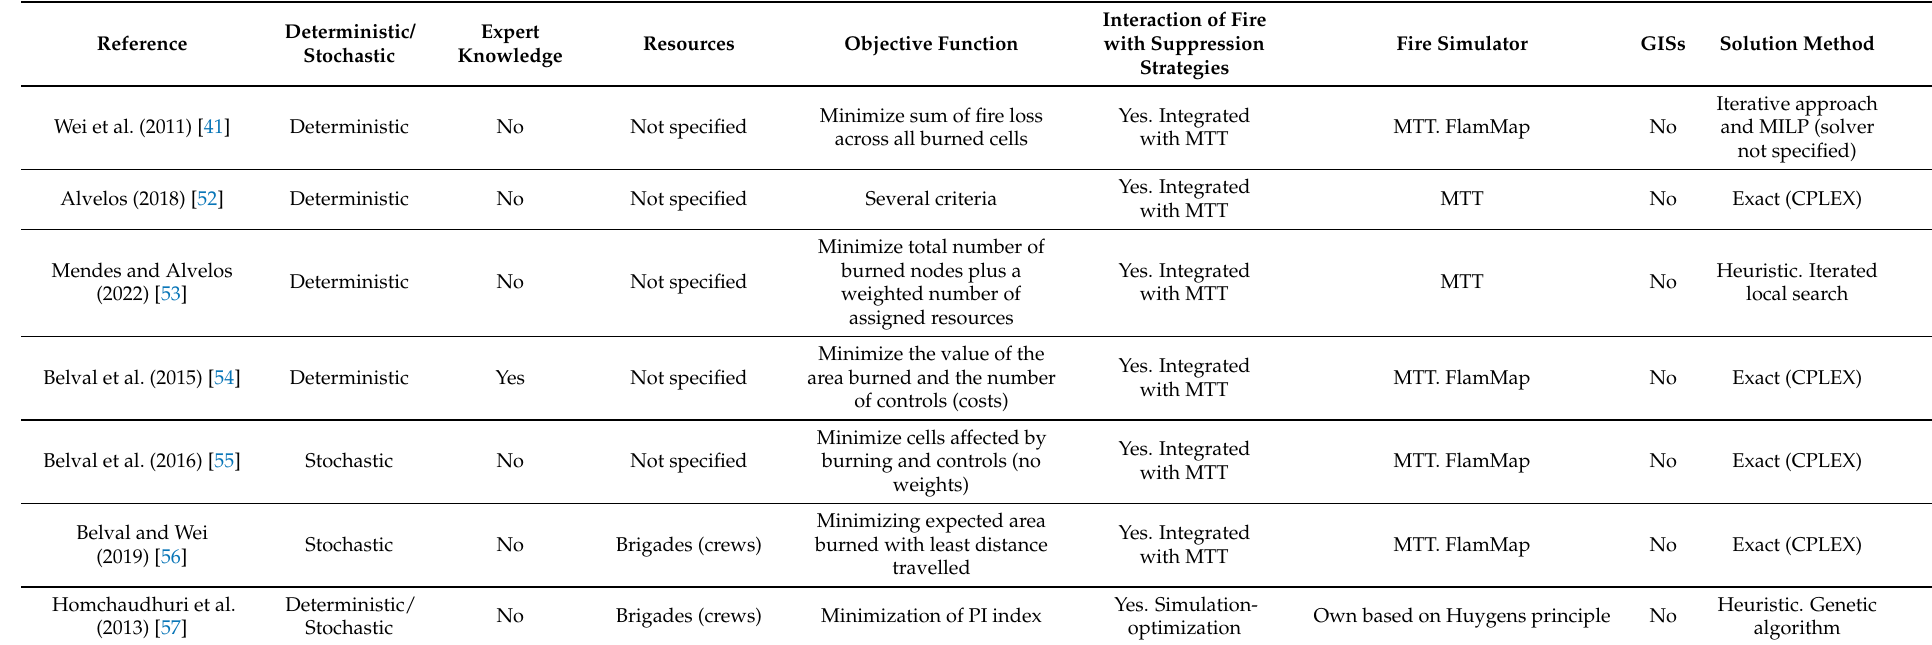
Table A4. List of main characteristics of papers that address the dispatch of resources for response.